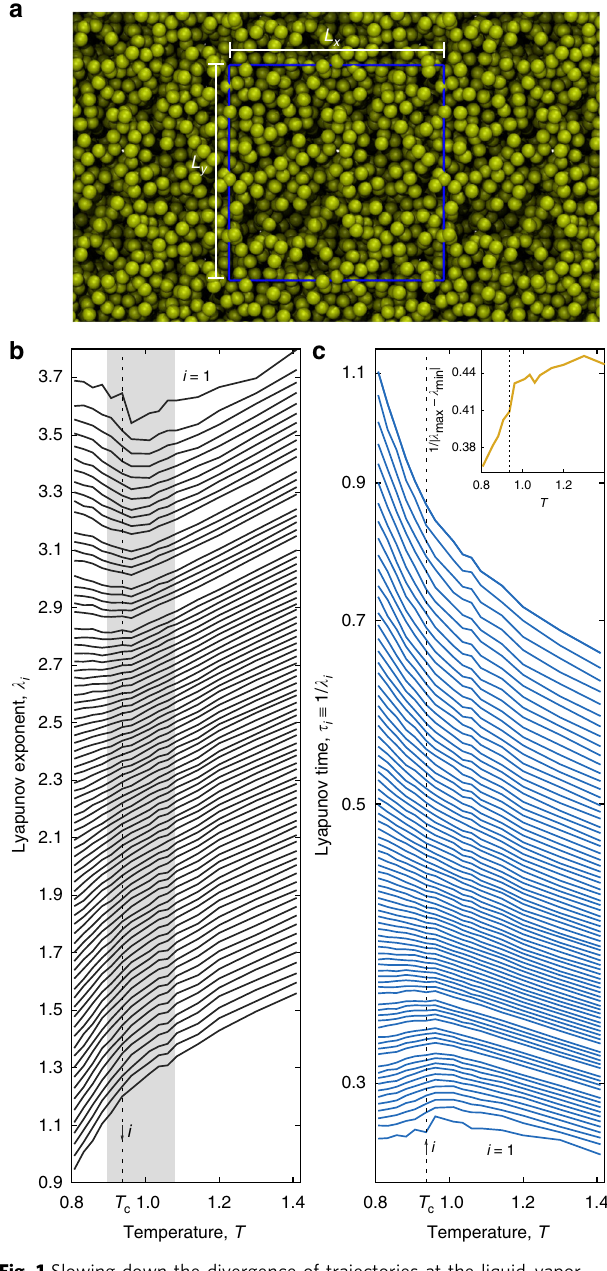
Fig. 1 Slowing down the divergence of trajectories at the liquid – vapor critical point. a Cross-sectional snapshot of the critical fl uid and the periodic boundaries of length L = L x = L y = L z . b Spectra of positive Lyapunov exponents λ i and c Lyapunov times τ i (log-linear scale) as a function of the mean kinetic temperature, T . Every 30 λ i are shown for N = 1000 particles occupying a cubic simulation volume with a density ρ = ρ c = 0.317. Unstable spatiotemporal vectors that correspond to more disordered motions (1/3 N ≤ i /3 N ≤ 0.18) have positive Lyapunov exponents (time) with a minimum (maximum). Vertical dashed lines mark the critical temperature, T c . Inset illustrates compression of spectrum through the critical point for data